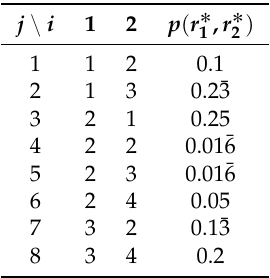
, r ˚ in Example 4. r ˚ 2 q 1 p